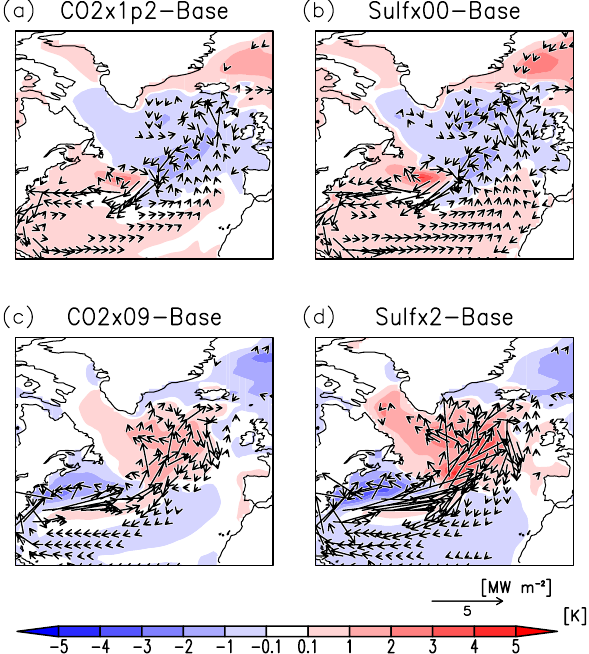
Figure 5. Anomalies of annual mean horizontal heat flux (vectors) with ocean temperature (colours) for CO2 × 1p2 ( a ), Sulf × 00 ( b ), CO2 × 09 ( c ), and Sulf × 2 ( d ) experiments from the base experiment in the North Atlantic. They are averaged below 100 m depth. Anomalies of the horizontal heat flux below 0.25 MW m –2 are not shown. The maps were generated with GrADS 2.2.1 (URL: http:// cola. gmu. edu/